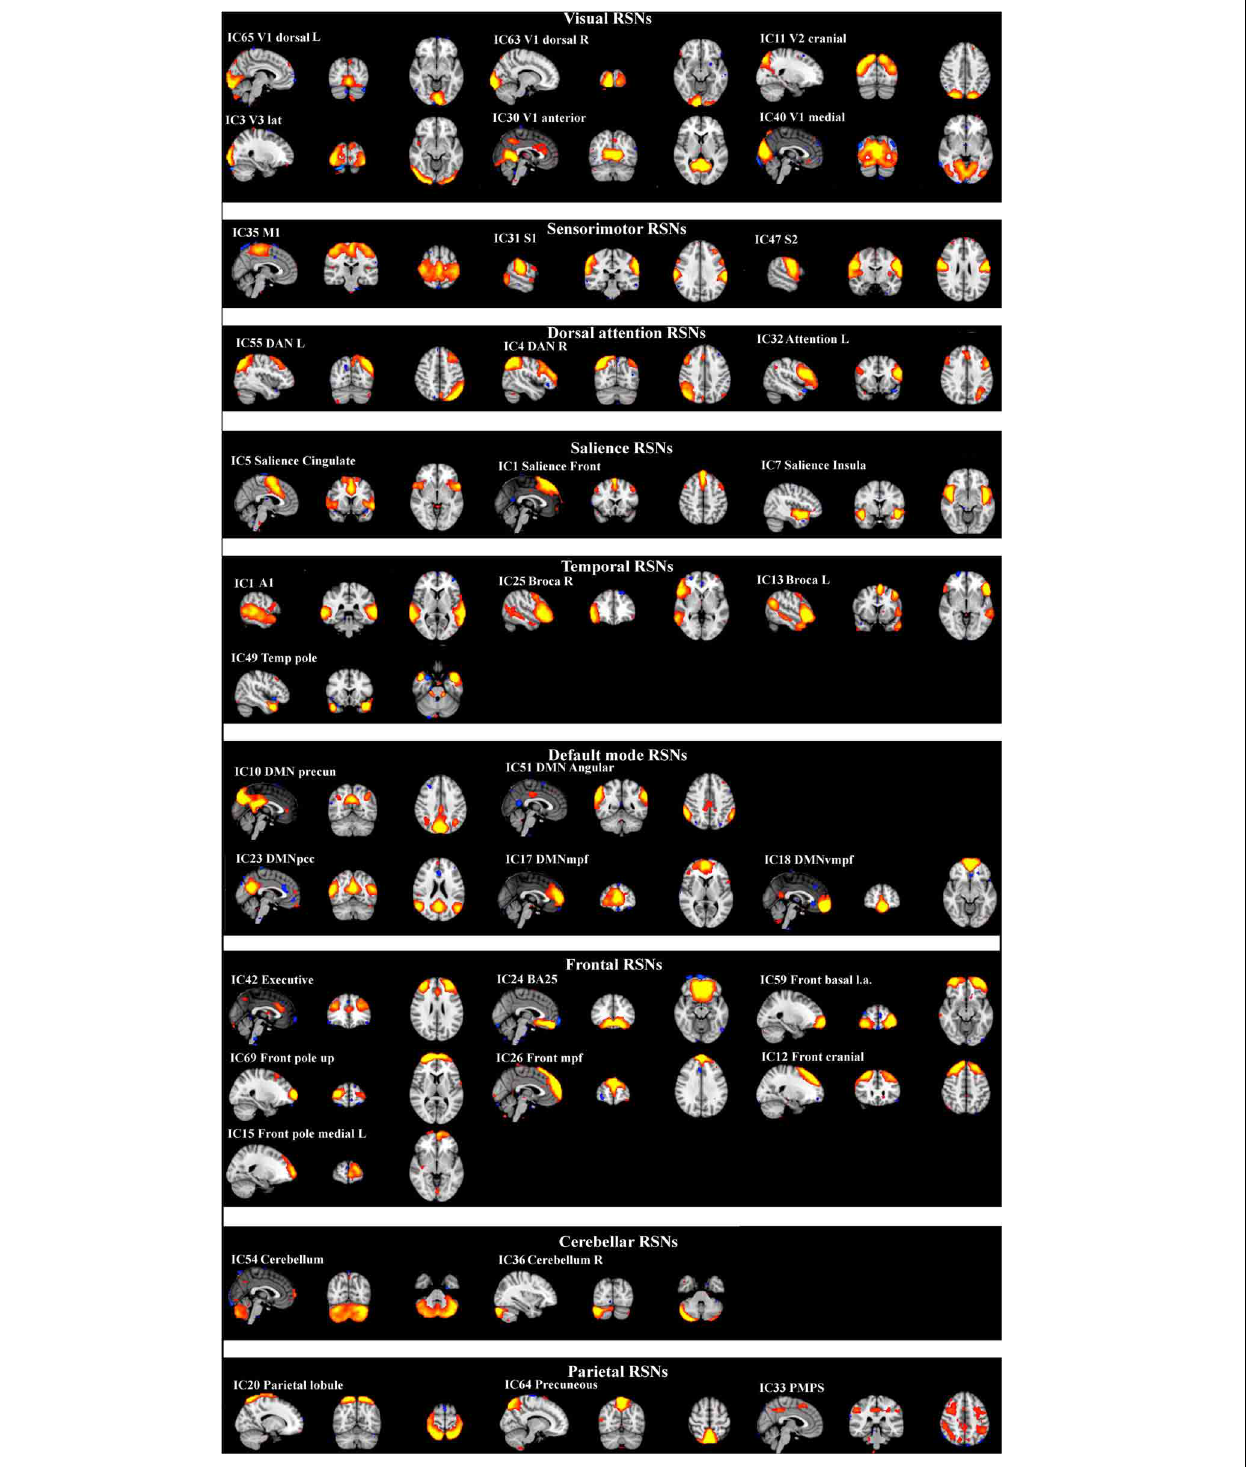
FIGURE 1 | Resting-state networks from the control group identified as anatomically and functionally classical RNSs and which were used for the dual regression analysis. The normal resting-state networks are shown in FSL red-yellow color encoding using a 3 < z -score < 9 threshold.